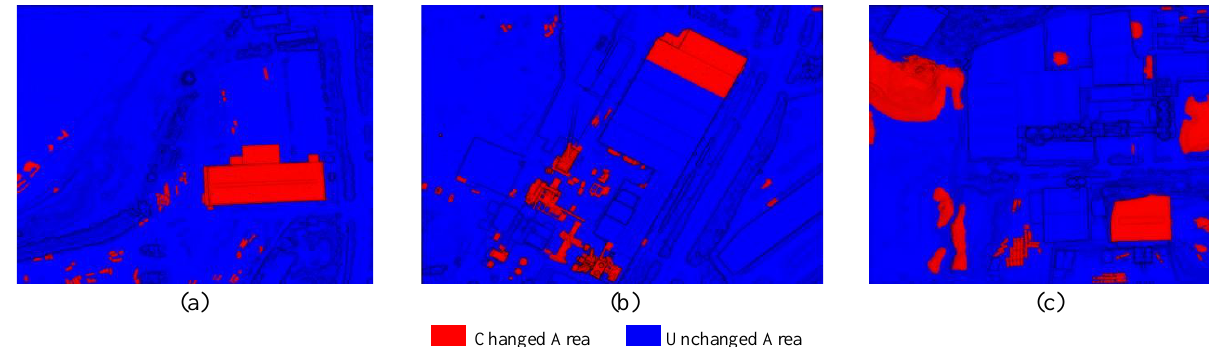
Figure. 4 Manually marked changed area: (a) is the marked data of area 1, (b) is the marked data of area 2, (c)is the marked data of